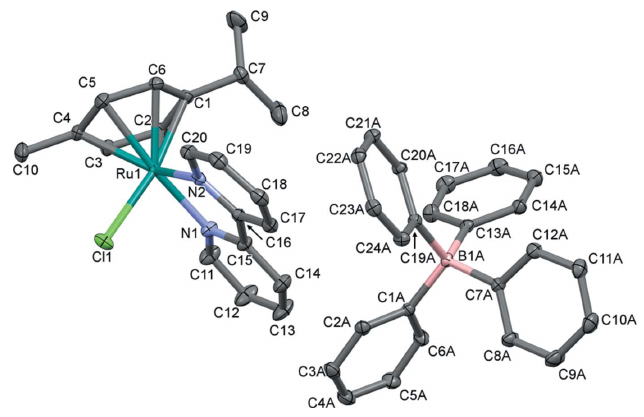
Figure 1 The molecular structure of complex 1 , with the atom labeling. Displacement ellipsoids are drawn at the 50% probability